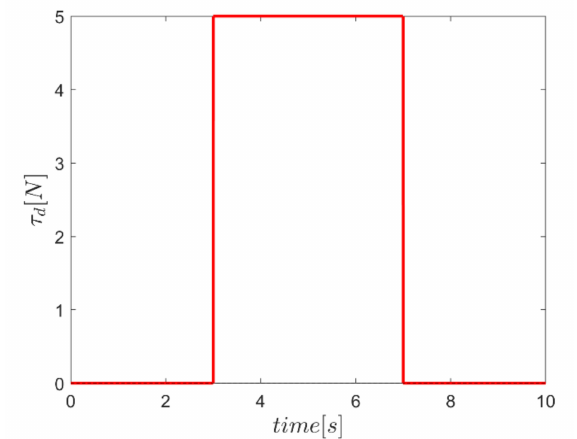
Figure 17. External square input disturbance in the vertical translation